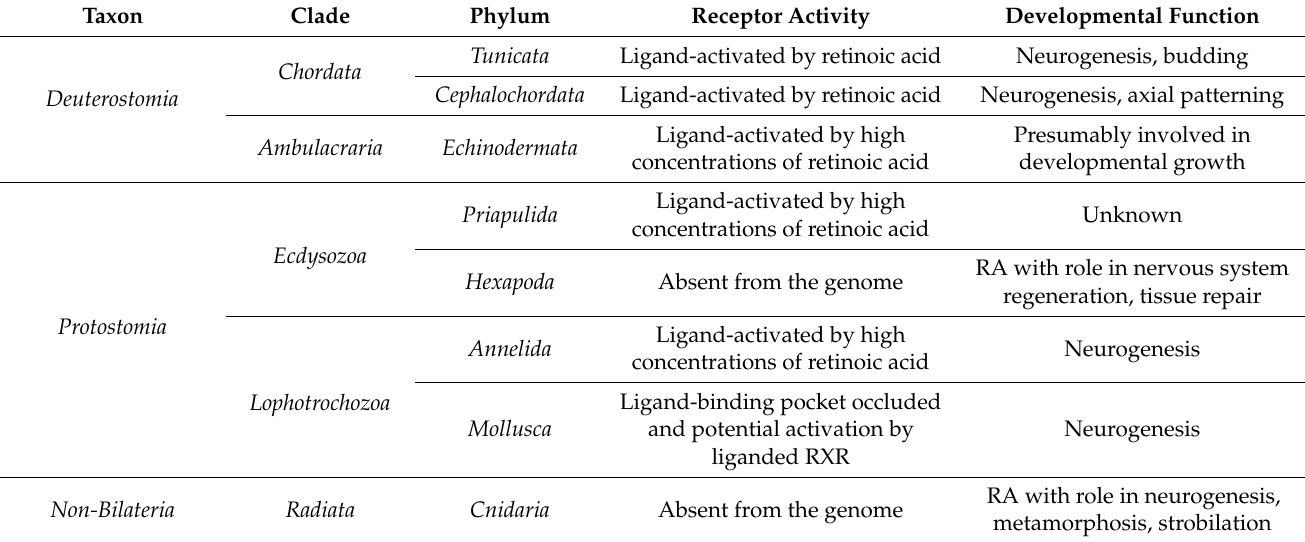
Table 3. Summary of retinoic acid receptor (RAR) functions in marine